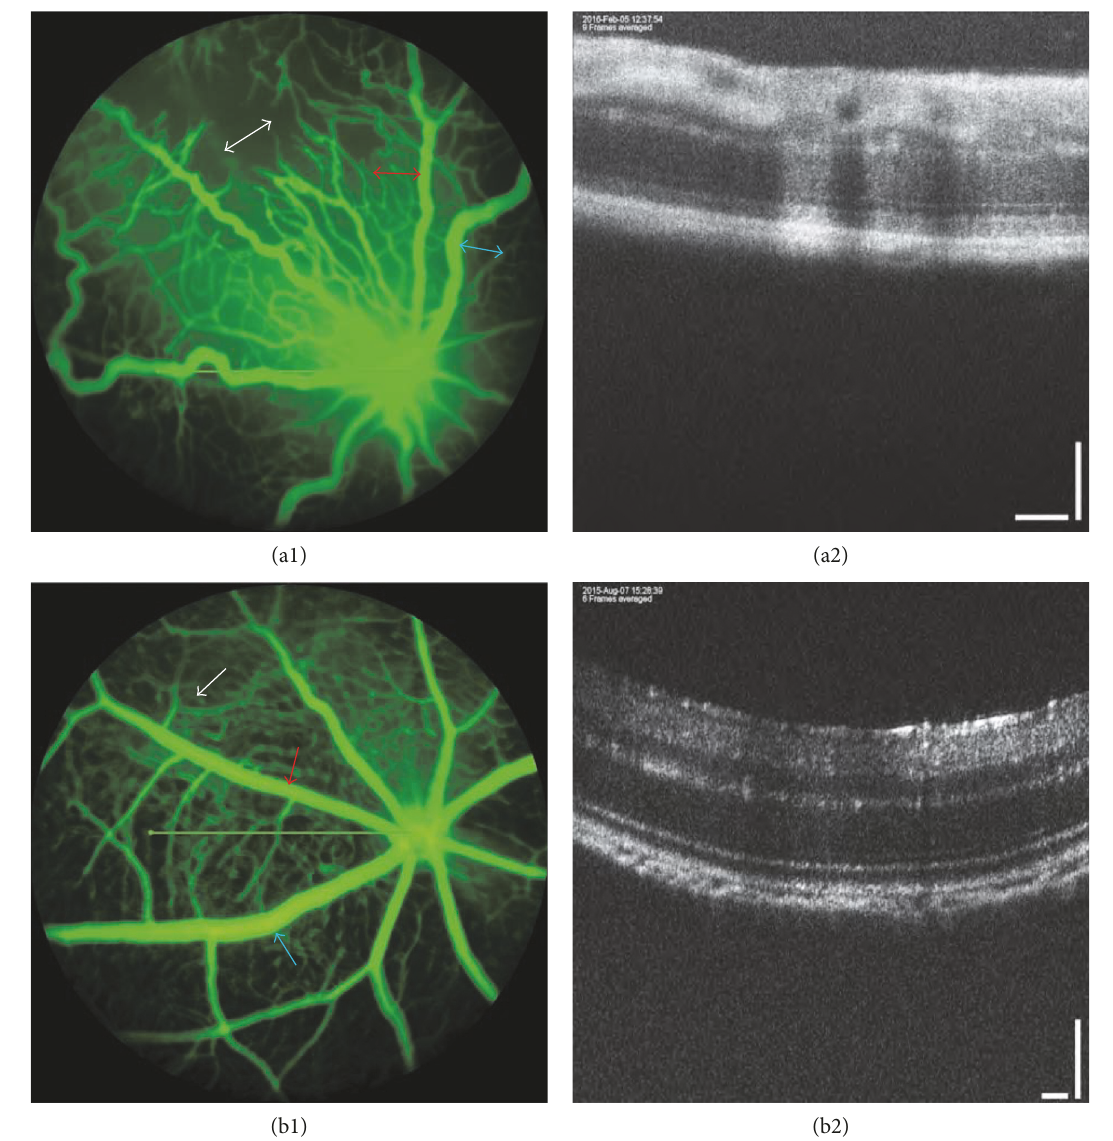
Figure 1: Fluorescein angiogram and corresponding spectral domain optical coherence tomography image at P24. (a1) FA of P24 OIR mouse depicting avascular retinal area in the superior retina (white double arrowhead), arterial tortuosity (red double arrowhead), and venous dilation (blue double arrowhead). (a2) Corresponding SD-OCT of the same P24 OIR mouse. (b1) FA of P24 RA mouse showing full capillary coverage with no avascularity in between major vessels (white arrow), nontortuous artery (red arrow), and normal width of vein (blue arrow). (b2) Corresponding SD-OCT of the same P24 RA mouse. Note: FA refers to fl uorescein angiogram; SD-OCT refers to spectral domain optical coherence tomography; RA refers to room